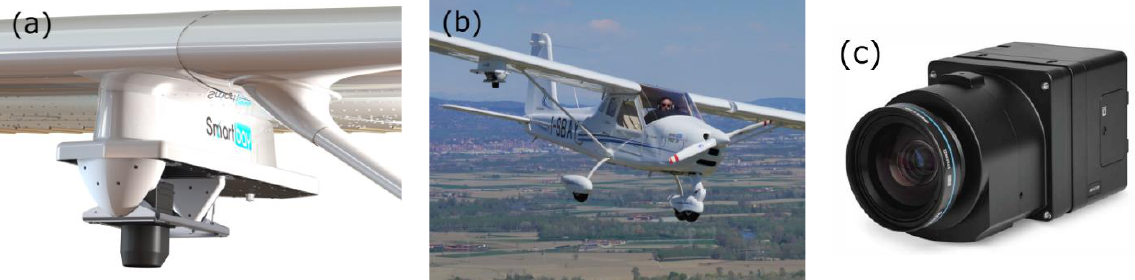
Figure 4. ( a ) SmartBay© platform; ( b ) Tecnam P92 JS aerial; ( c ) Phase-One iXM-RS150F RGB camera.